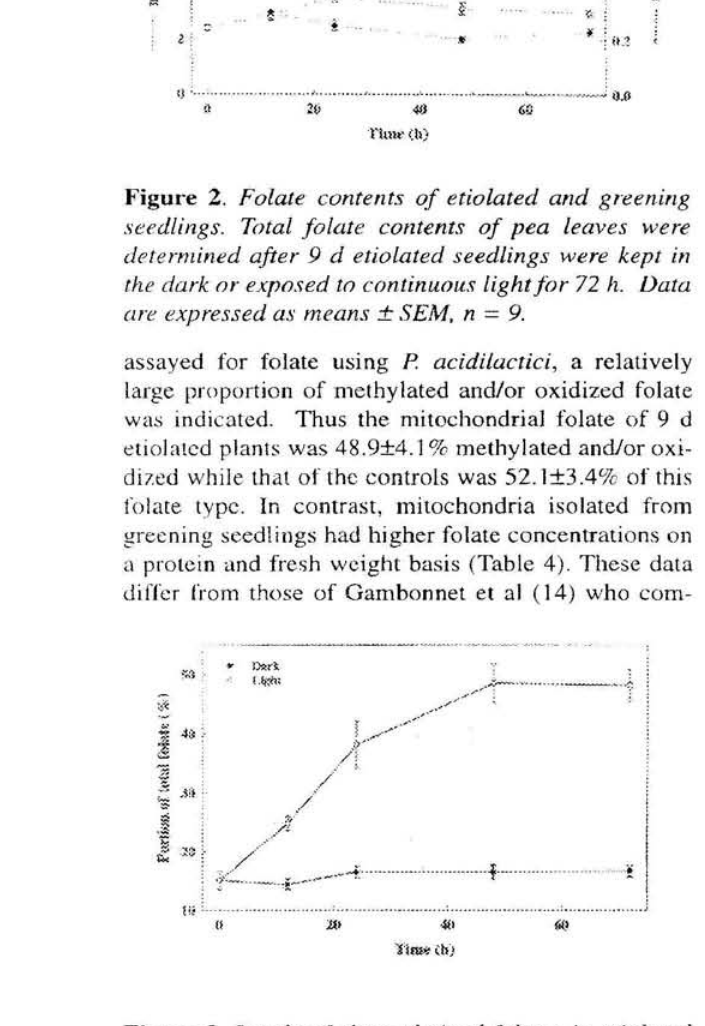
Figure 3. Levels of short-chained folates in etiolated Extracts of etiolated and green- with L. rhamnosus